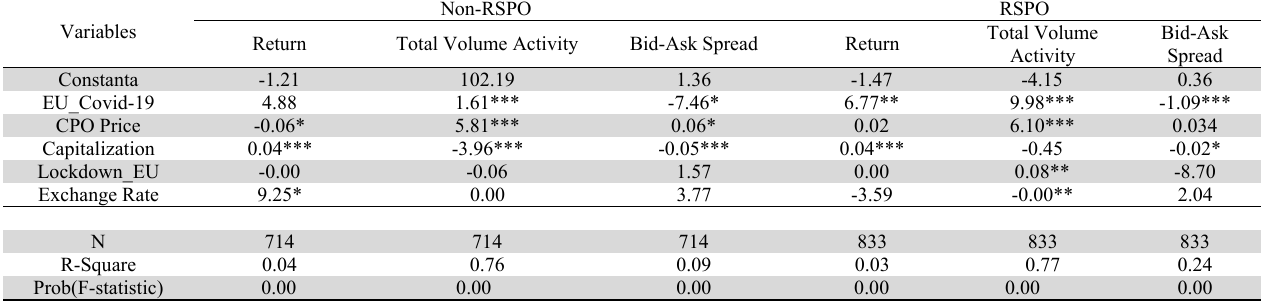
Panel Regression Estimation (RSPO and Non-RSPO